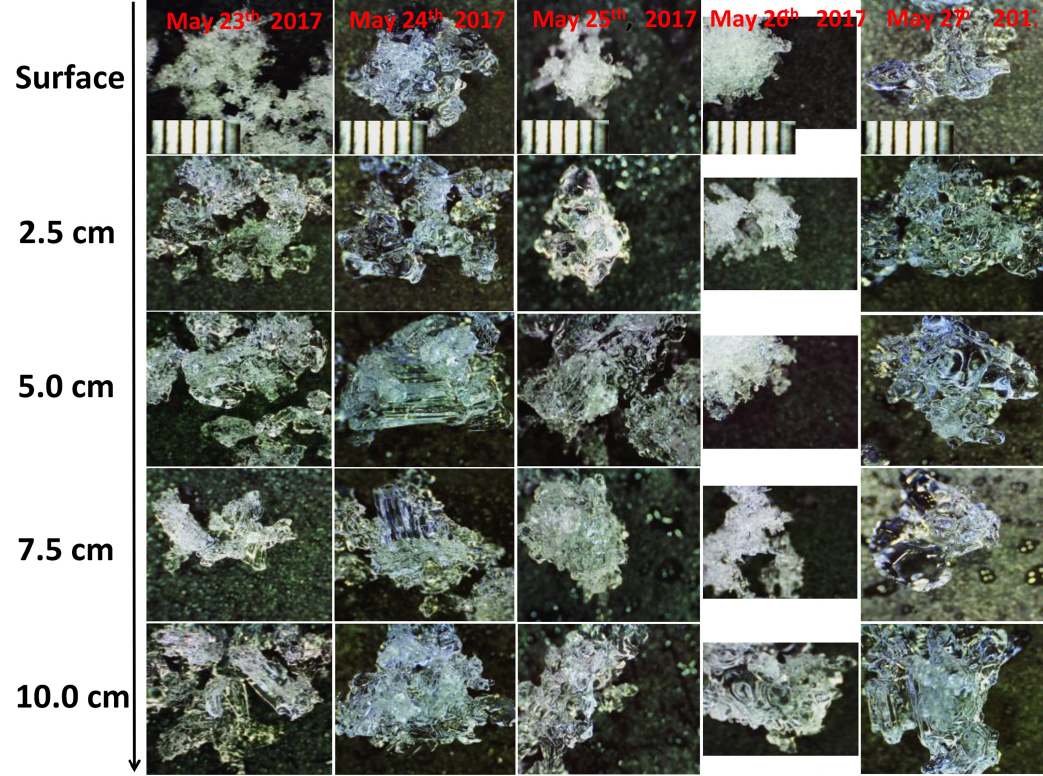
Figure 4. Observed snow morphology at different depths of the snowpack over ice in the Chukchi Sea north of Utqia˙gvik from 23 May through 27 May 2017. The reference ruler is 0.5mm